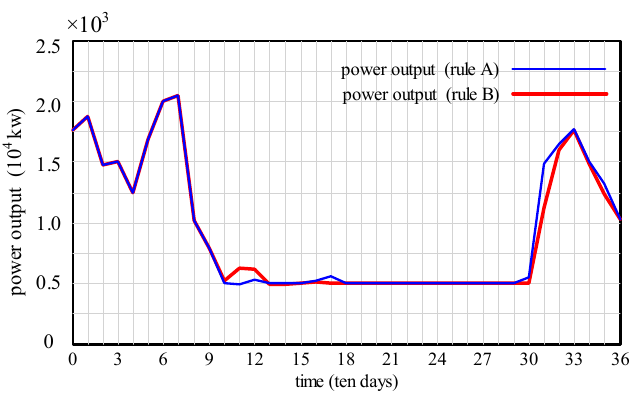
Figure 13. Power output process of TGR decided by operating rules A and B (the operating period is 11 June 2001 to 11 June 2002).